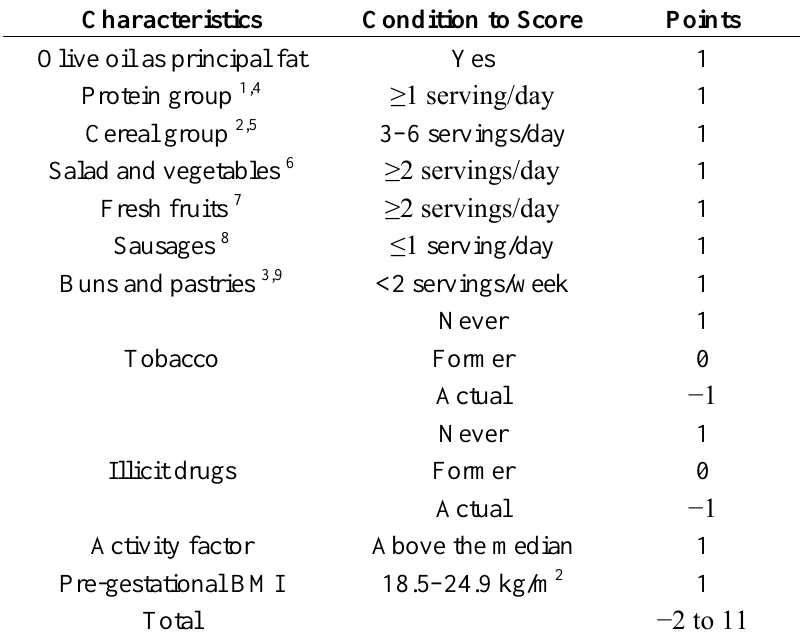
Table 3. Definition of the healthy lifestyle